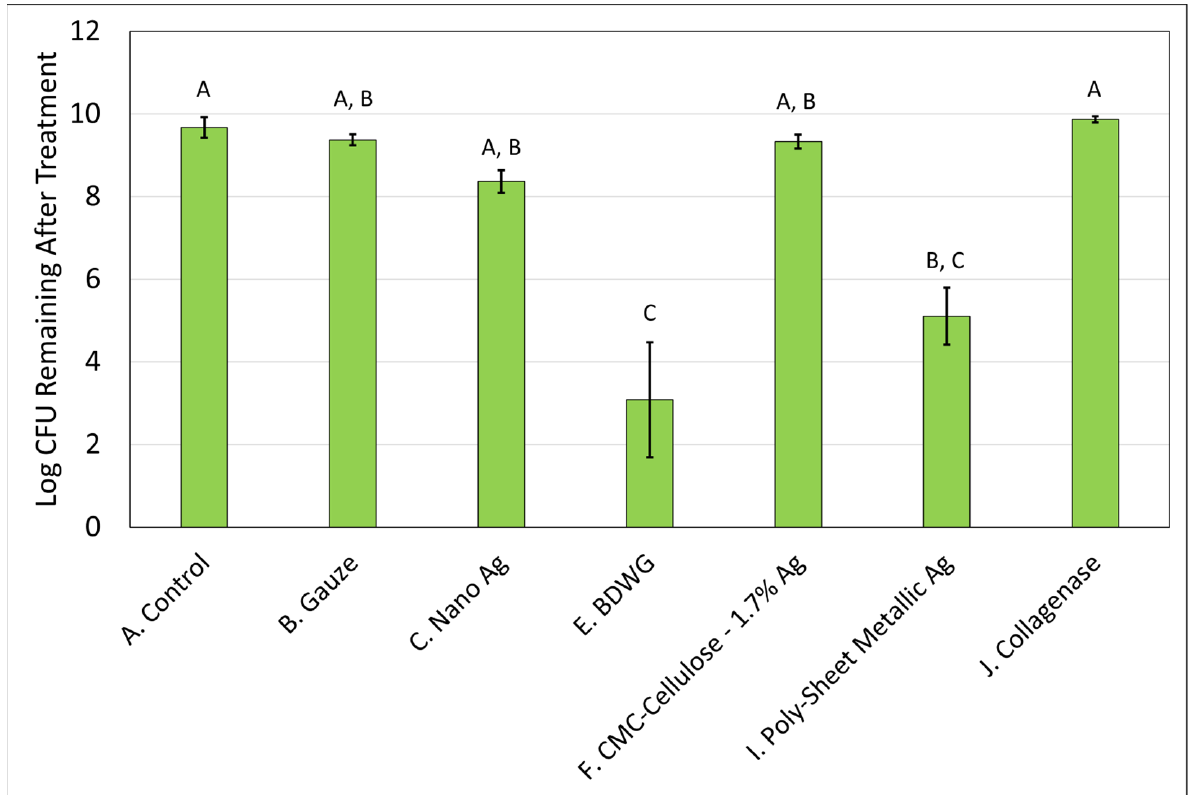
Figure 6. Log CFU/cm 2 of P. aeruginosa remaining in mixed-species mature biofilms after 24 h of treatment. If treatments have the same letter listed above the column, they are not statistically different at p = 0.05. The error bars depict the standard error of mean. Table 2. Log CFU reduction of S. aureus and P aeruginosa species in comparison with untreated controls in a mixed-species DFR mature biofilm treatment